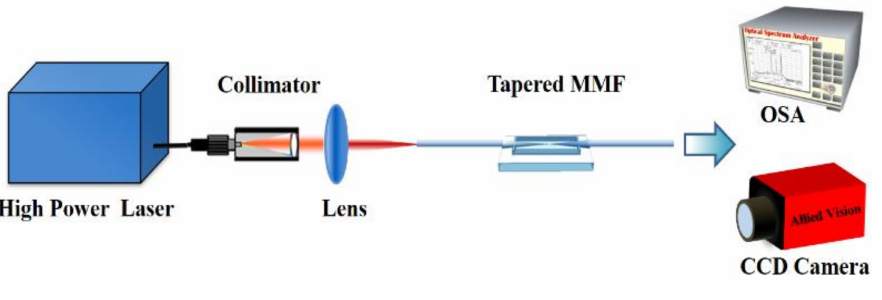
Figure 1. Schematic of the experimental setup for observing the spatial beam self-cleaning.